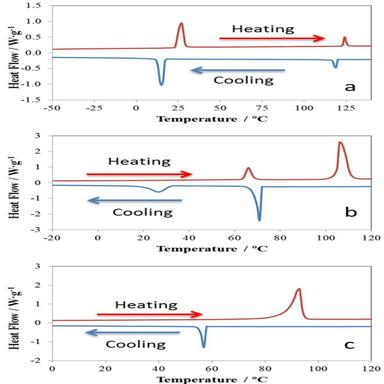
Cooling (blue) and heating (red) scans of DSC curves (exo down) obtained at 5 C min1 for the three choline based ionic liquids: a) , b) , c) (For interpretation of the references to colour in this figure legend, the reader is referred to the web version of this article.)